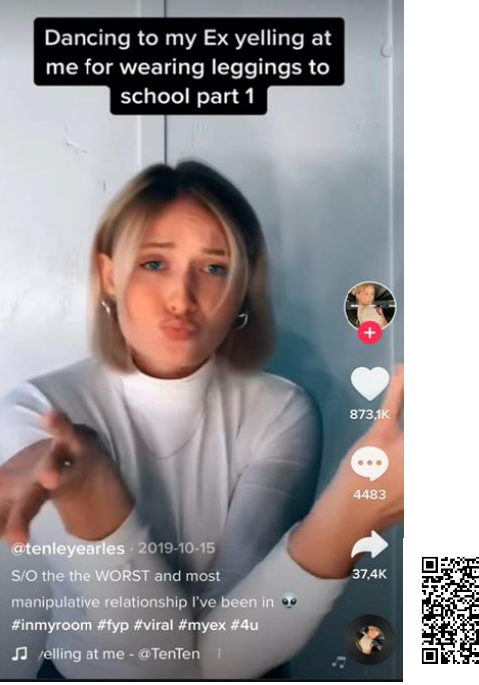
Figure 2. @Tenleyearles performing to audio message.